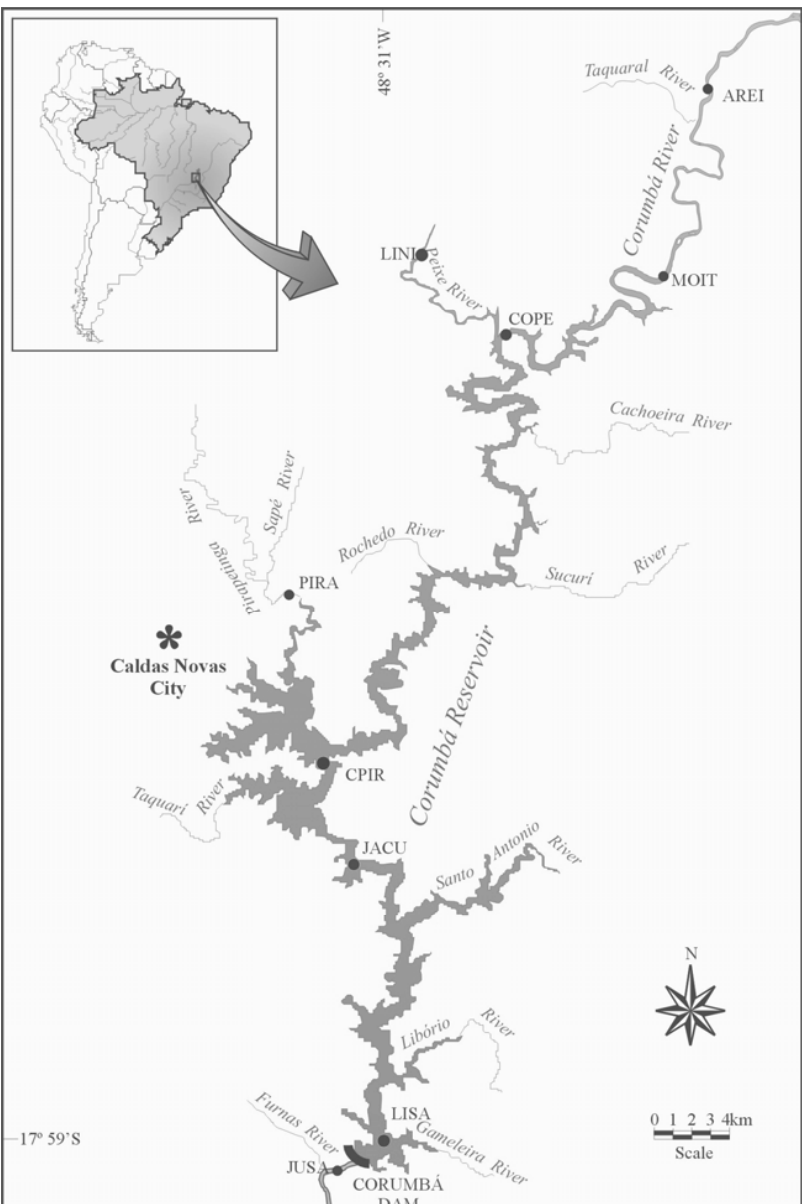
Fig. 1 – Map showing position of sampling sites ( •